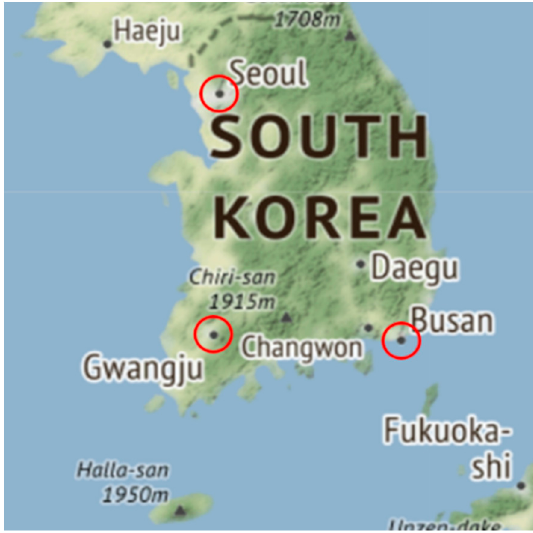
Figure 5. Geographical locations of Seoul, Gwangju, and Busan in South Korea.